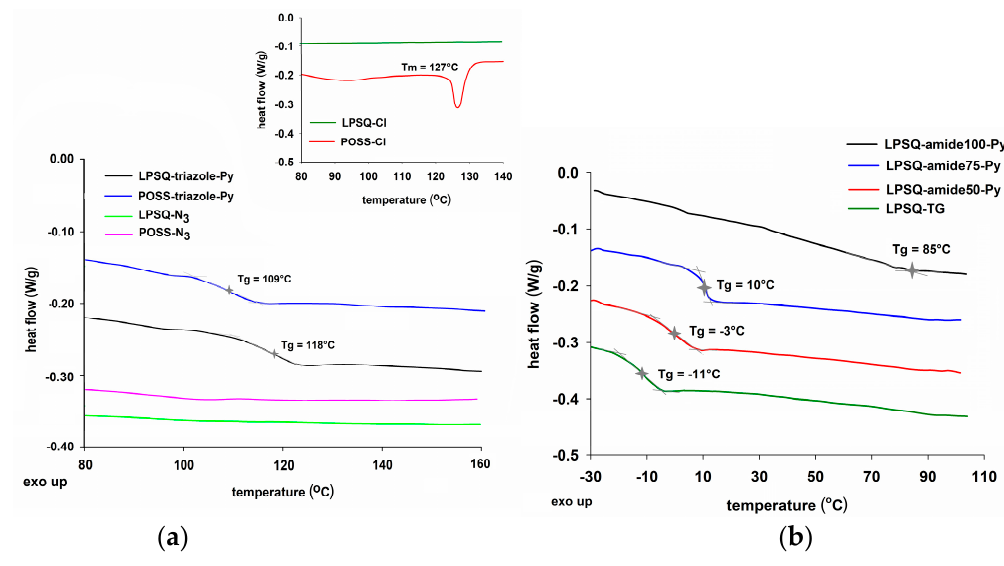
Figure 4. Thermal analysis of ( a ) LPSQ and POSS-triazole-Py (inset: LPSQ-Cl and POSS-Cl) ( b ) LPSQ-amide-Py. DSC traces recorded at a heating rate of 10°C/min (3rd run).